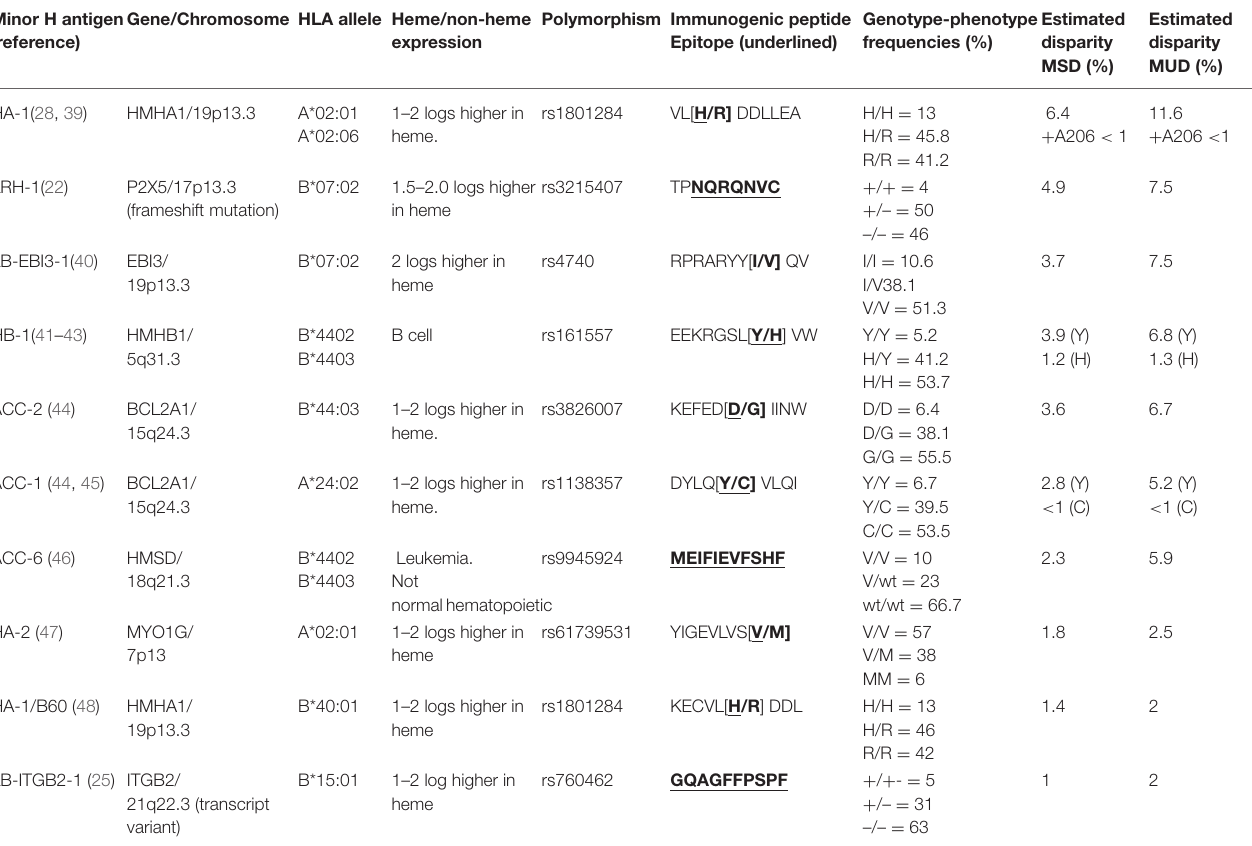
TABLE 1 | Selected hematopoietic-restricted minor H antigens of interest for therapeutic targeting. Minor H antigen Gene/Chromosome HLA allele Heme/non-heme (reference)